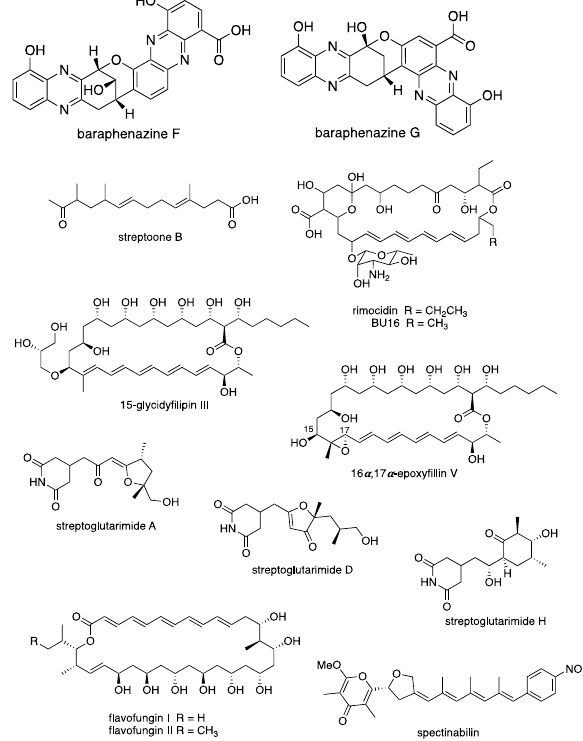
Figure 8. Examples of new compounds isolated from Streptomyces spp. between 2015 and 2020 with antifungal activity. 6.8. Other Biological Activity There were also new natural products from Streptomycetes , which show other bio- logical activities as described in Table 13 below. A total of 18 different bioactivities were recorded from 23 Streptomyces spp., which produced 45 bioactive compounds in total be- tween 2015 and 2020 (Table 13). Figure 9 showed some examples of new compounds isolated from Streptomyces spp. with other biological activity.